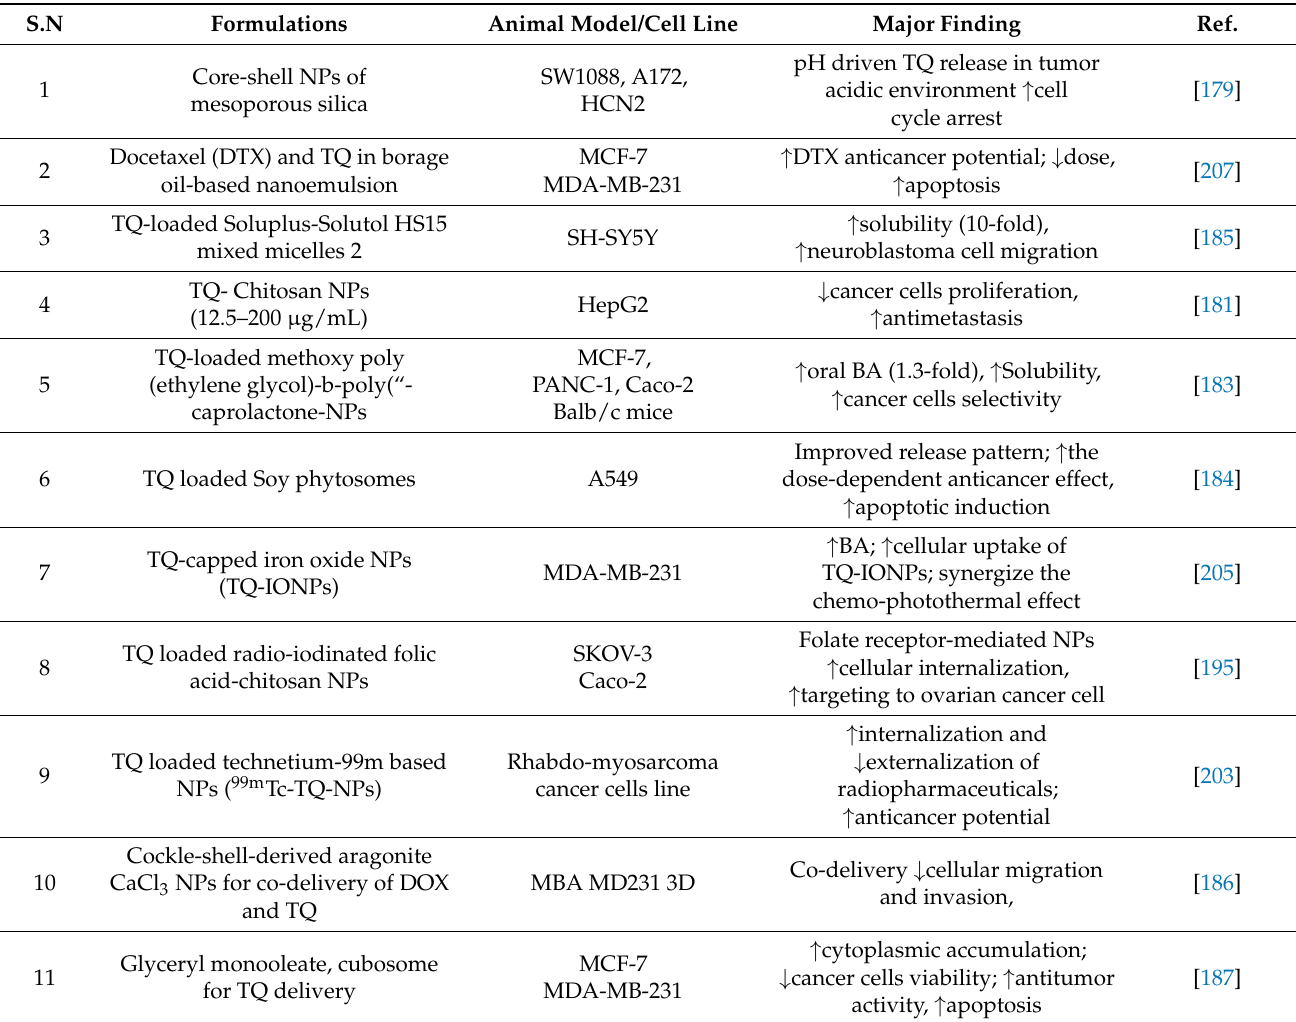
Table 5. TQ nanocarrier in the management of cancer and inflammation ( ↓ : decrease, ↑ : increase). S.N Formulations Animal Model/Cell Line Major Finding